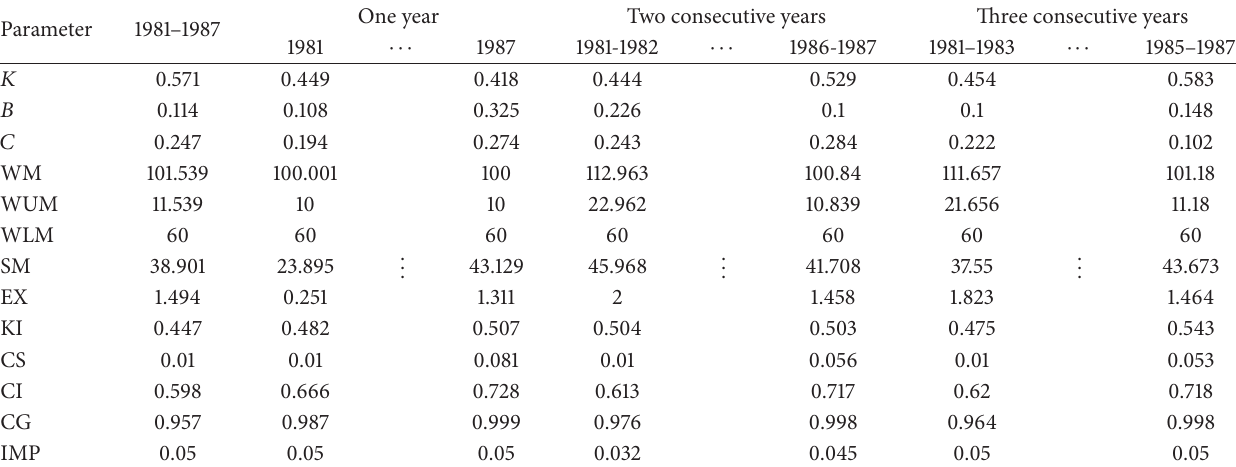
Table 9: Parameter optimization results using measured